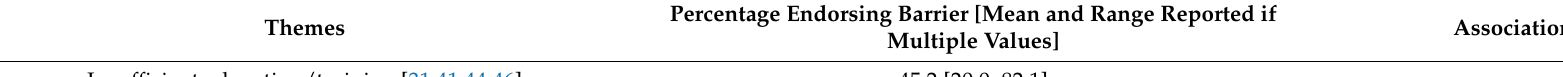
Table 3. Primary care providers’ perceptions of barriers associated with conducting breast cancer risk